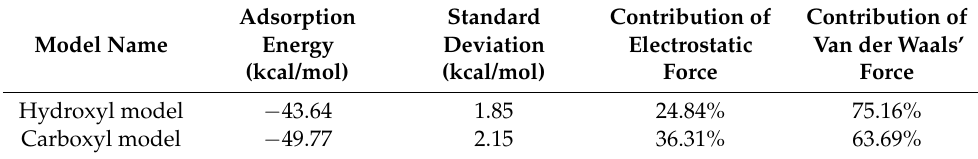
Figure 15. Equilibrium adsorption conformation. ( a ) Hydroxyl group-top view; ( b ) hydroxyl group- side view; ( c ) carboxyl group-top view; ( d ) carboxyl group-side view. Table 5. Adsorption energy and energy contribution of hydroxyl and carboxyl groups.